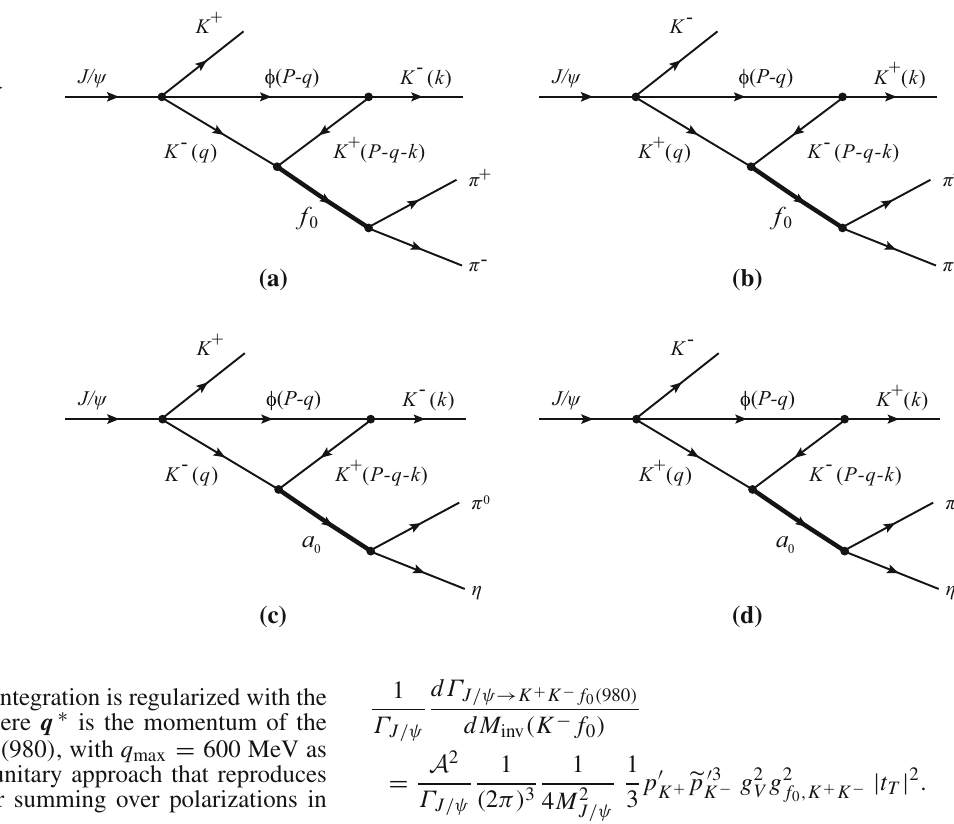
Fig. 3 Triangle diagrams for the a , b J /ψ → K + K